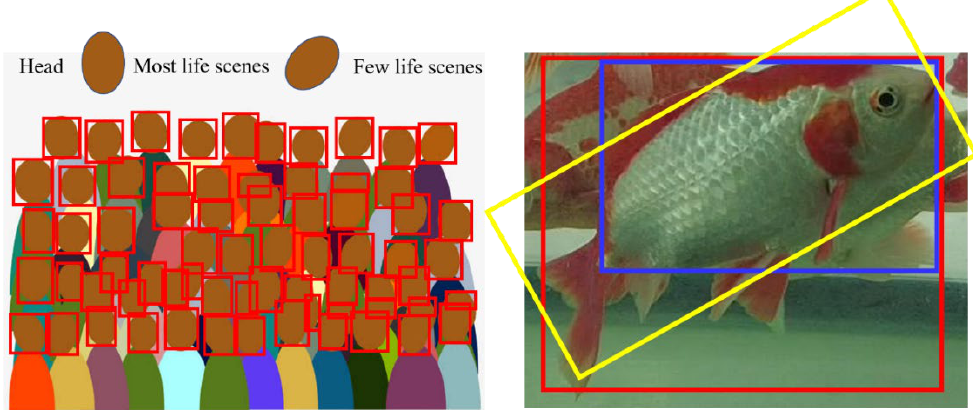
Figure 4. The left figure simulates face detection in a real environment. Each red standard box can box the face with little repetition. The yellow box on the right is a rotating box, the red box retains all the features of the fish and the blue box discards some of the features of the fish.